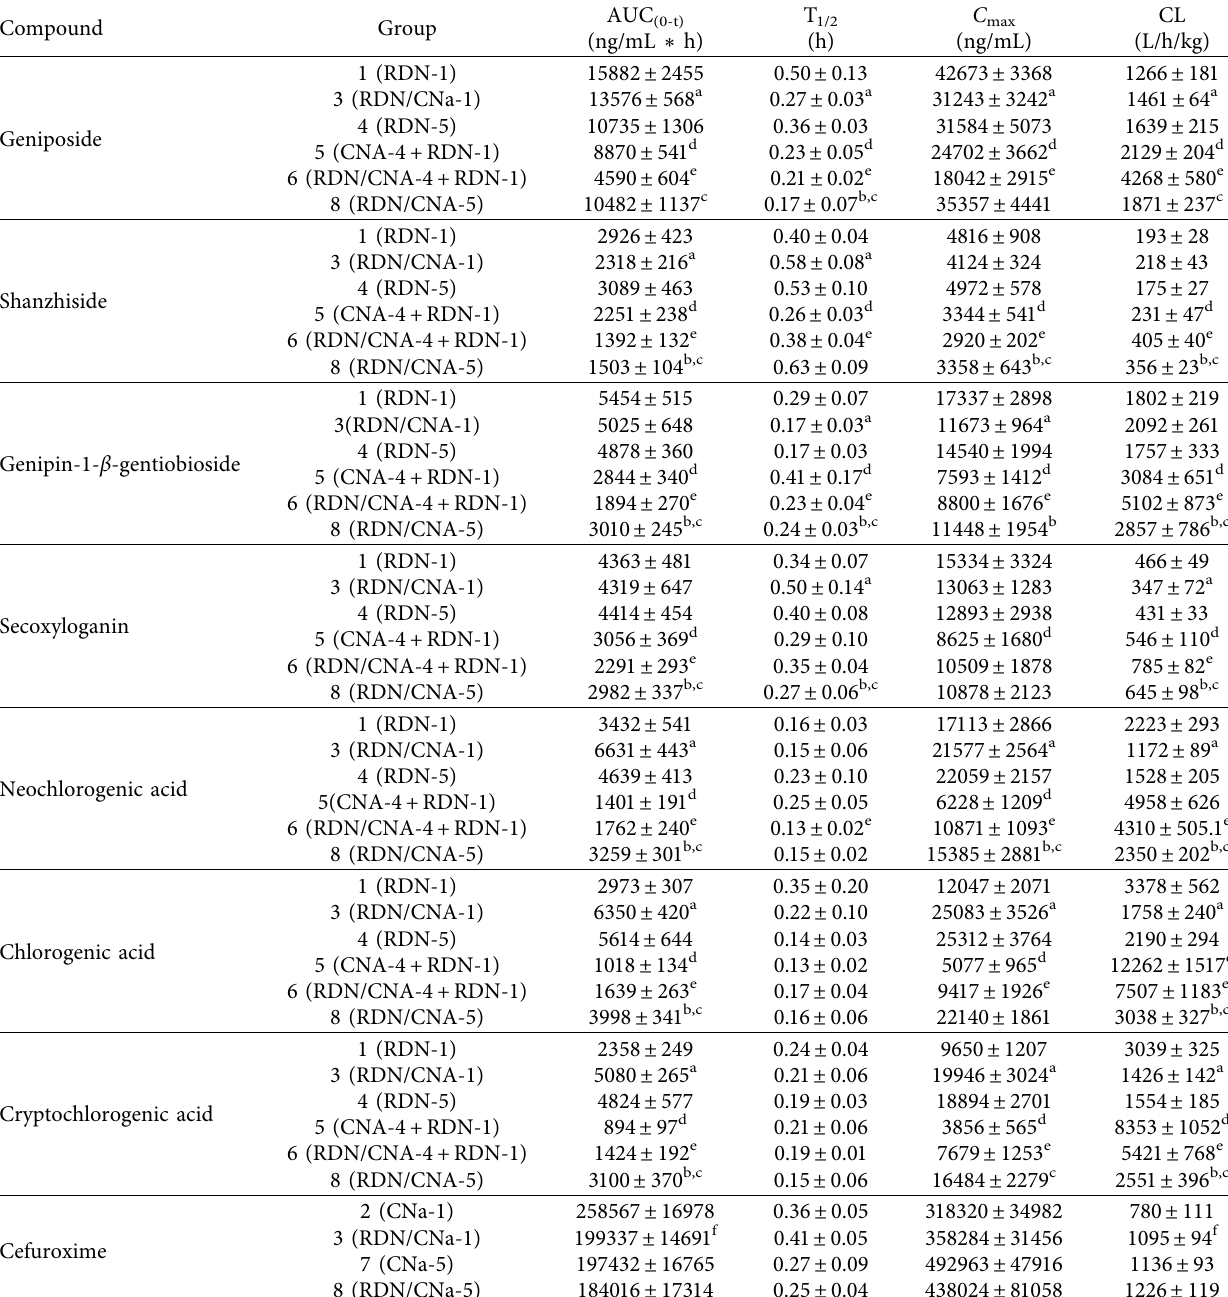
Table 6: The pharmacokinetic parameters of the compounds in rat plasma after intravenous coadministration of RDN and CNa. Compound Group